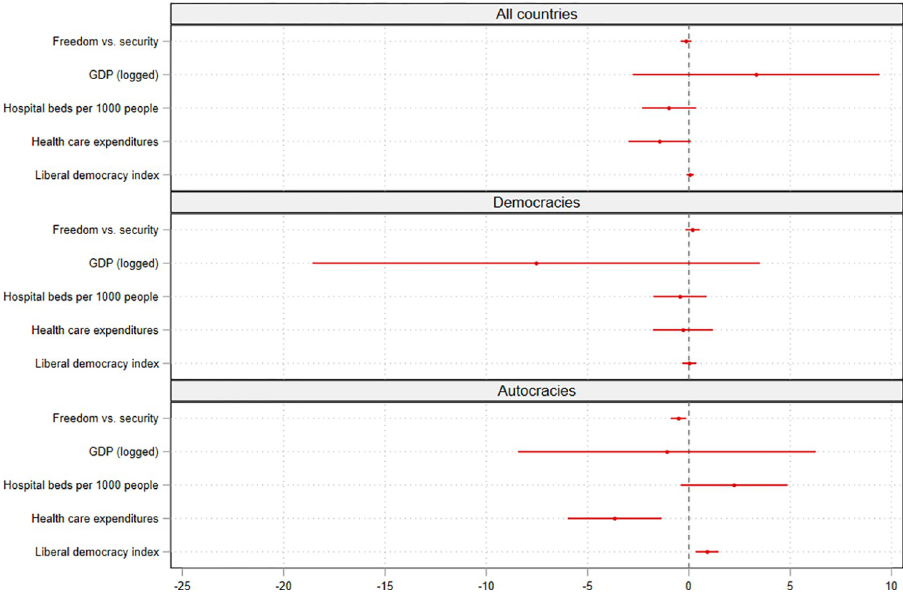
Fig 2. Random effects models for the Stringency Index. Notes: Coefficients are statistically significant if the 95% confidence intervals do not cover zero. Full regression tables are shown in Tables 2 and 3 (model 5).